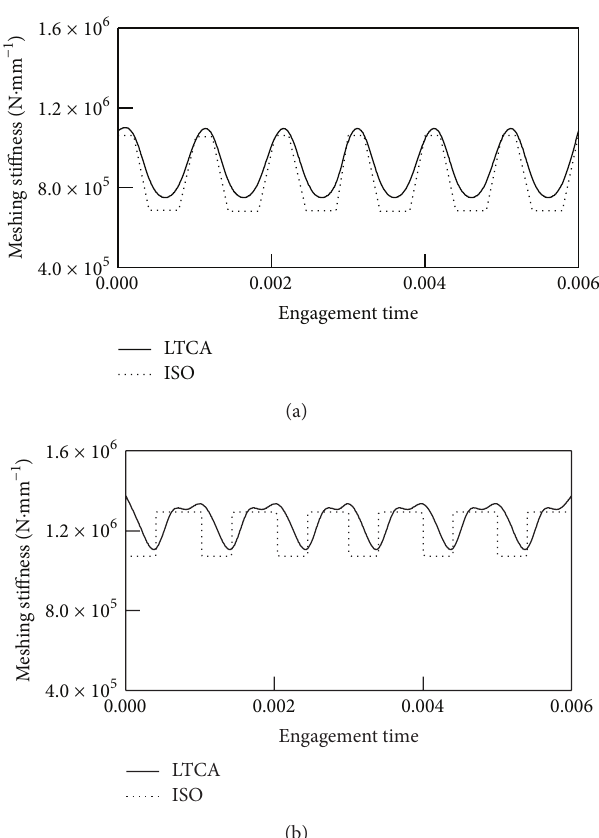
Figure 7: The curves of time-varying mesh stiffness incentive. Illustration of (a) level-I helical gear pairs and (b) level-II spur gear pairs.